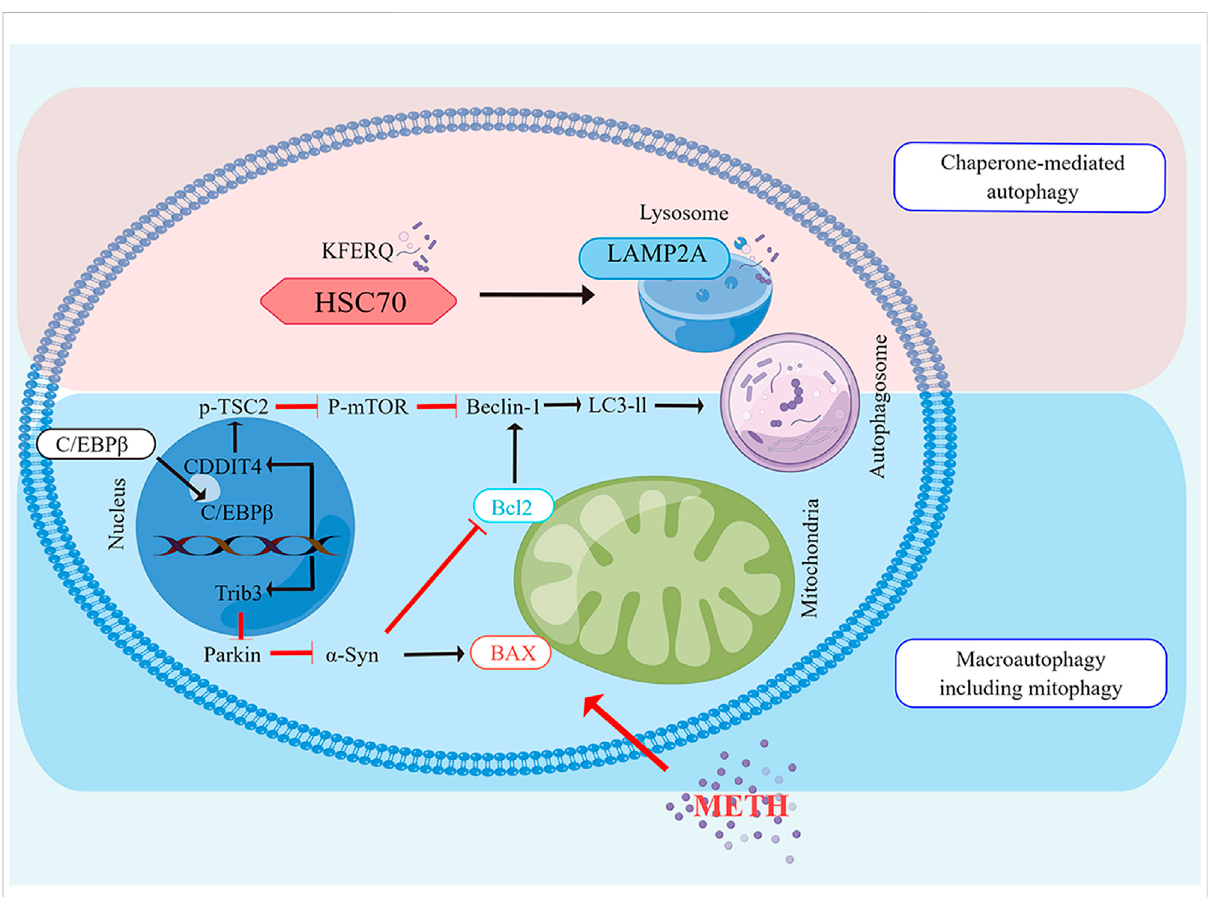
FIGURE 2 The Molecular pathways of autophagy induced by METH NeurotoxicityThe CMAand macro autophagyare both enhanced by METH. Beclin1 is a vital protein in both autophagy pathways that are associated with Bcl2. Macro autophagy is induced by METH via C/EBP β , either by induction of C/ EBP β /DDIT4 /TSC2/m TOR or by induction of C/EBP β /Trib3/Parkin/ α -Syn. In the CMA induced by METH, the chaperone, HSC70, detects a KFERQ- like motif in the cargo protein. Lipid complexes with the LAMP2A. Translocation of LAMP2A through the lysosomes follows its assembly. Upon entering the lysosome, the substrate protein undergoes rapid degradation by proteases, and then HSC70 is released from the lysosome to bind to another